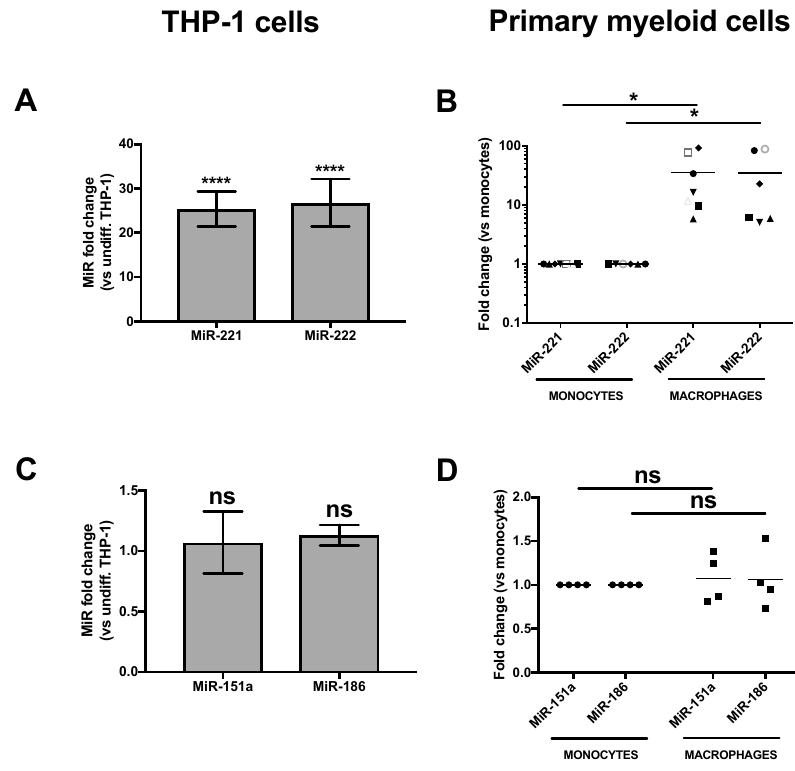
Figure 3. MiR-221 and miR-222 expression is enhanced in THP-1 cells or MDMs following differentiation. * p < 0.05 and **** p < 0.0001. The expression of miR-221 or miR-222 was compared in THP-1 cells prior or after differentiation ( A : n = 11; means ± SD are shown and compared using Student’s t test), or monocytes and corresponding macrophages from at least 6 blood donors ( B : n = 6 donors represented by different symbols; bars represent mean values which are compared using Mann-Whitney’s U test), respectively, by qRT-PCR. MiR-151a and miR-186, which expression did not significantly change in the RNAseq (Figure 2), were also analyzed in THP-1 ( C : n = 3) or primary cells ( D : n = 4 blood donors) as validation